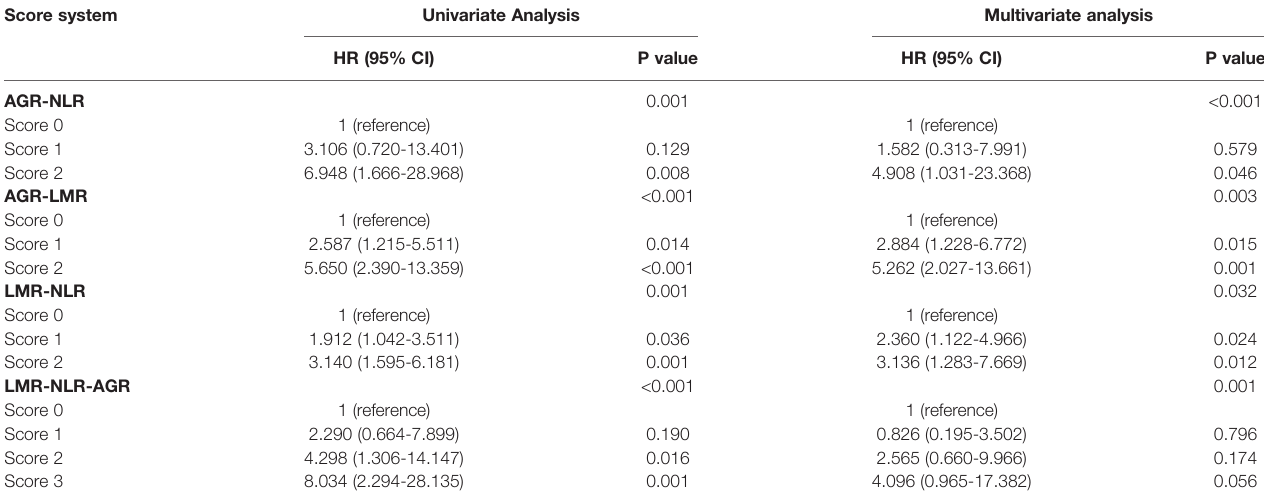
TABLE 4 | Univariate and multivariate analyses for OS in GBM cohorts based on score